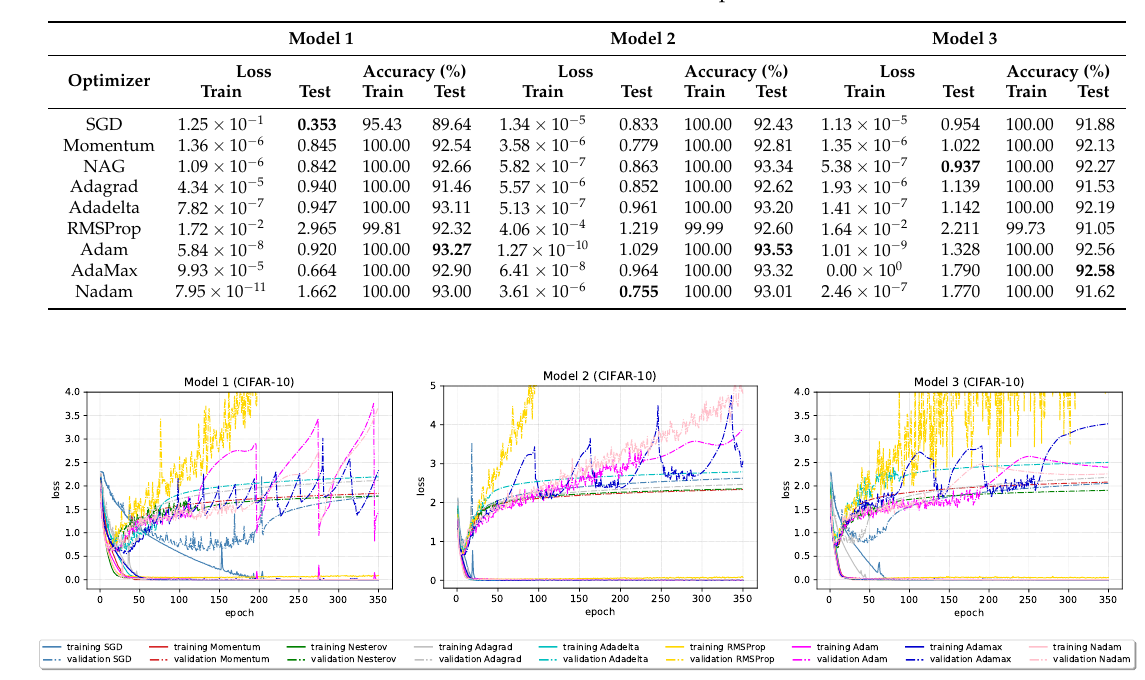
Table 3. Performance of baseline models trained with different optimizers on Fashion-MNIST dataset.